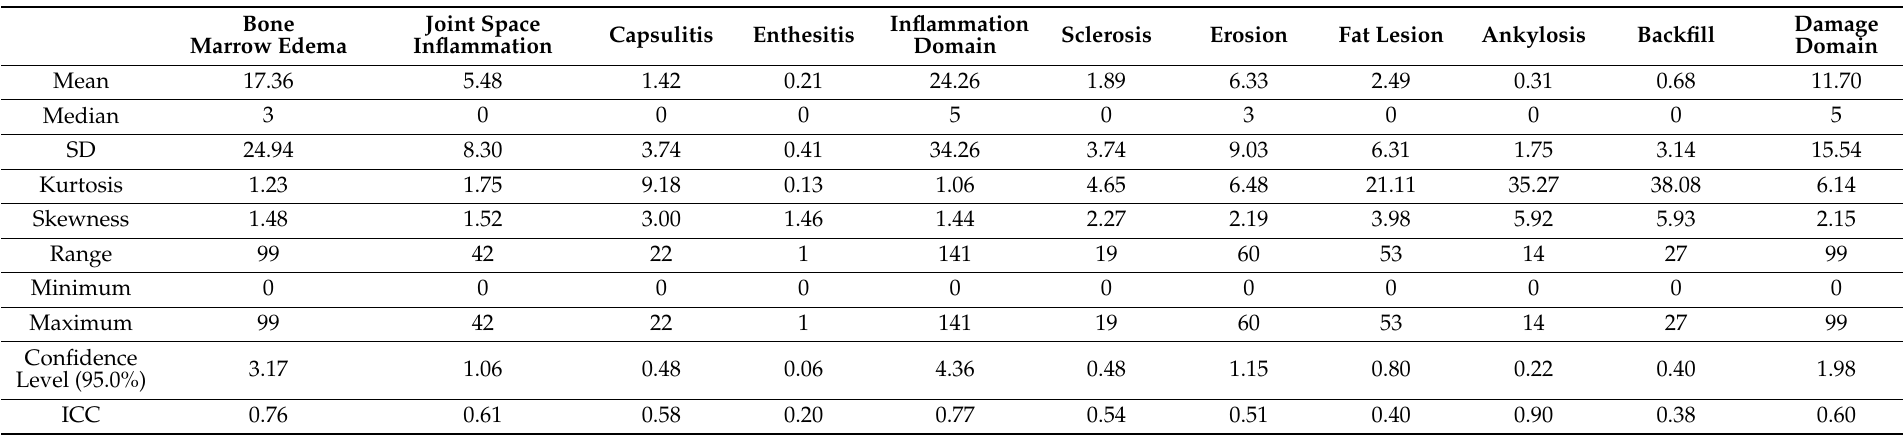
Table 2. JAMRIS-SIJ inflammation and damage component descriptive statistic and intraclass correlation coefficients (ICCs) for both radiologists and rheumatologists. Bone Joint Space Capsulitis Marrow Edema Inflammation